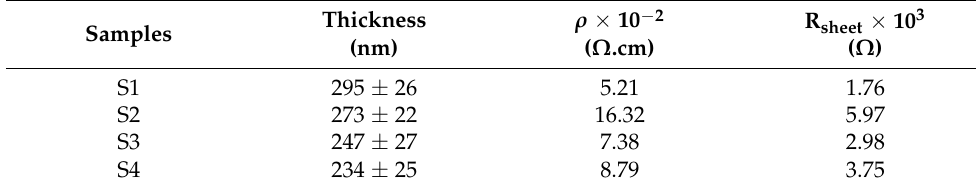
Table 1. Profilometry and four-point